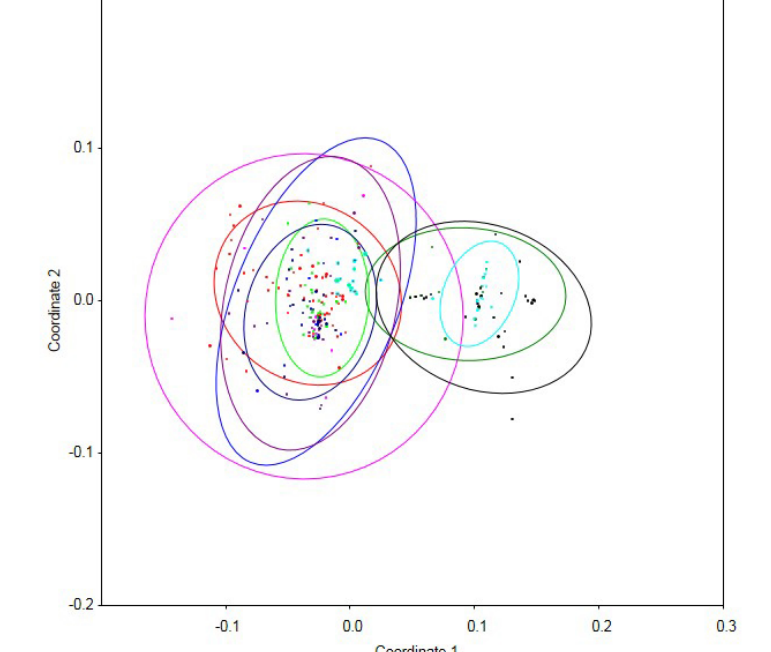
Fig. 91. Comparison of the type population of Fragilaria rinoi Almeida & C.Delgado sp. nov. with the type material of related taxa. Data fitted to 95% confidence ellipses. NMDS plot of Bookstein- transformed valve outline pseudolandmark coordinates. Black: F. rinoi sp. nov. Red: F. candidagilae Almeida, C.Delgado, Novais & S.Blanco. Blue: F. capucina Desm. Pink: F. intermedia Grunow in Van Heurck. Olive green: F. microvaucheriae C.E.Wetzel & Ector. Purple: F. neointermedia Tuji & D.M.Williams. Green: F. perminuta (Grunow) Lange-Bert. Dark blue: F. recapitellata Lange-Bert. & Metzeltin. Sky blue: F. vaucheriae (Kütz.)